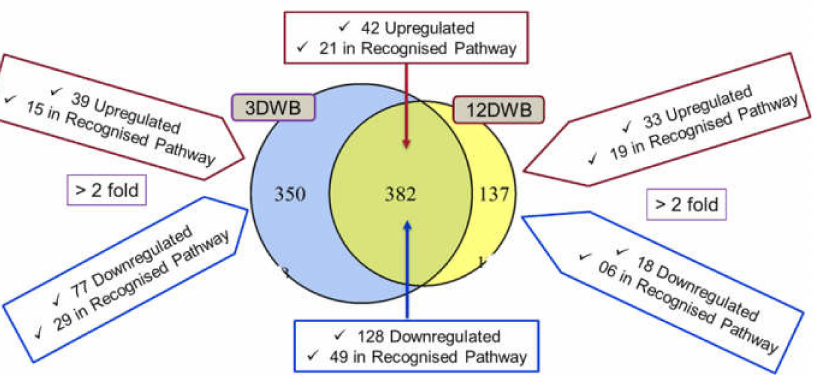
Figure 1. Venn diagram shows the dispersion of common and significant differential proteins in 3dwb and 12dwb. Pathway analysis was performed using KEGG.